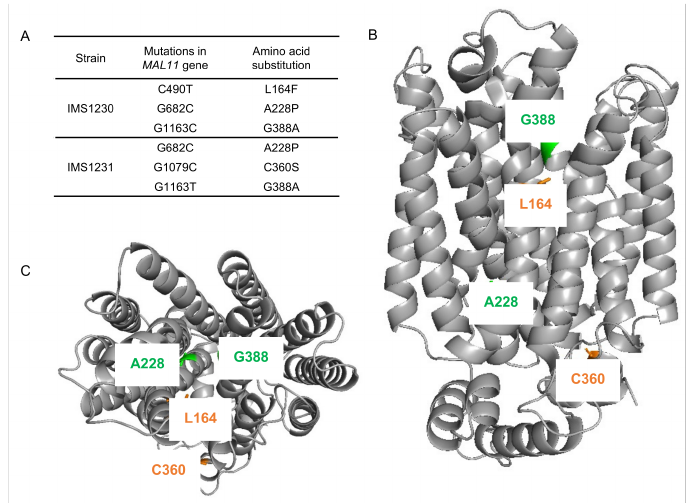
Figure 3. Mutations identified in MAL11 after evolution of IMZ786 ( sugar 0 MAL11 ) in two indepen- dent, glucose-limited continuous cultures with increasing addition of sucrose. ( A ) In single-colony isolates from two independent reactors, three mutations were identified in MAL11 . ( B ) (side view), ( C ) (top view). Structural model of Mal11, highlighting the location of the amino acid changes resulting from the mutations that occurred during evolution. Mutations that were identical in both strains are indicated in green, and mutations that were unique in each strain are indicated in orange. All structure figures were prepared with PyMol.